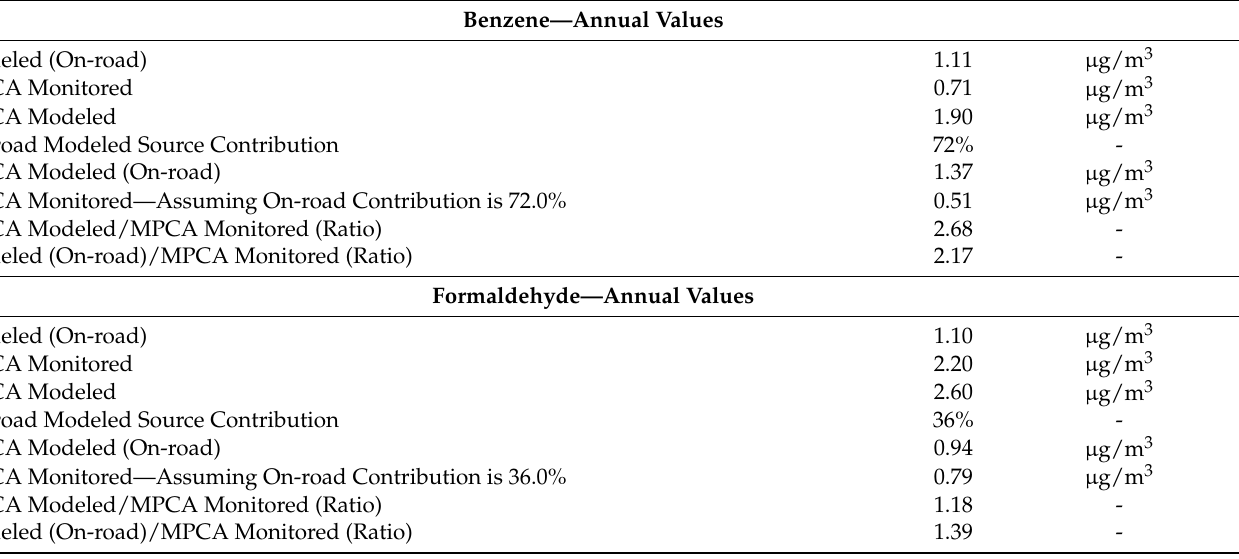
Table 16. Modeled On-Road Air Concentrations Compared to Annual Mean Monitored Concentra- tions at the Saint Paul—Ramsey Health Center Monitoring Site.